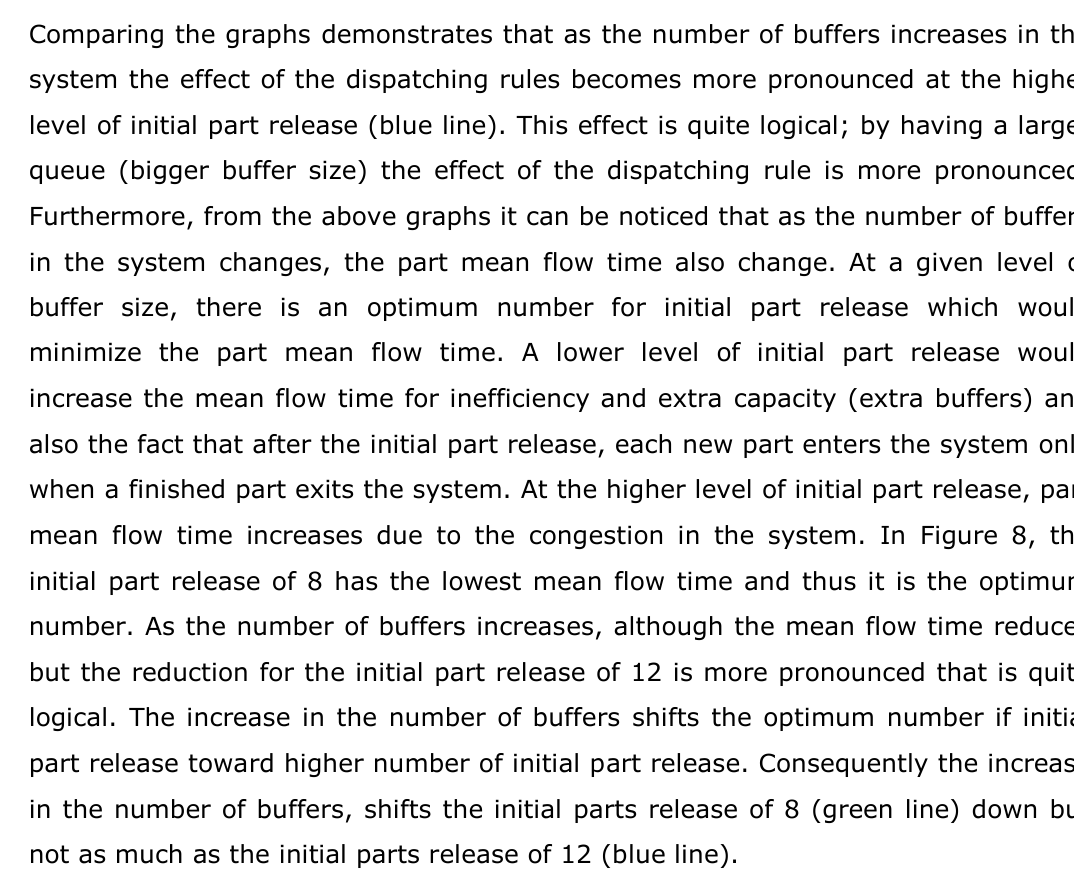
Figure 10. Average flow time, initial part release & buffer size for SPT Finally the effect of the number of the buffers in the system can also be seen in Figures 8 to